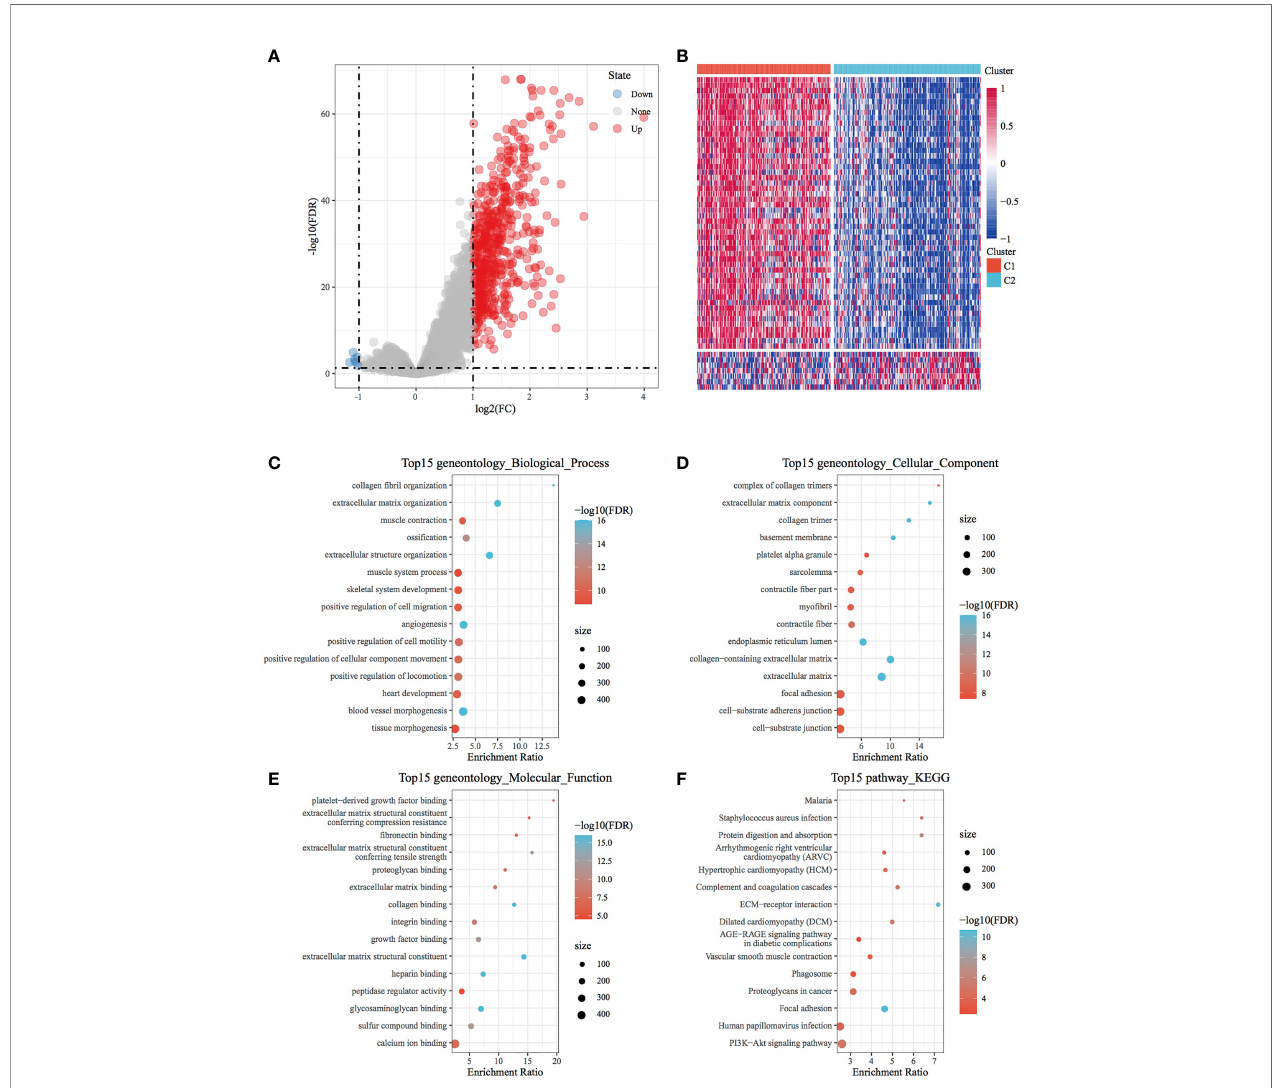
FIGURE 2 | Identi fi cation and functional analysis of DEGs between molecular subtypes. (A) Volcano map of DEGs between the C1 and C2 subtypes. (B) Heat map of DEGs between the C1 and C2 subtypes. (C) BP annotation map of differentially upregulated genes in the molecular subtypes. (D) CC annotation map of differentially upregulated genes in the molecular subtypes. (E) MF annotation map of differentially upregulated genes in the molecular subtypes. (F) KEGG annotation map of differentially upregulated genes in the molecular